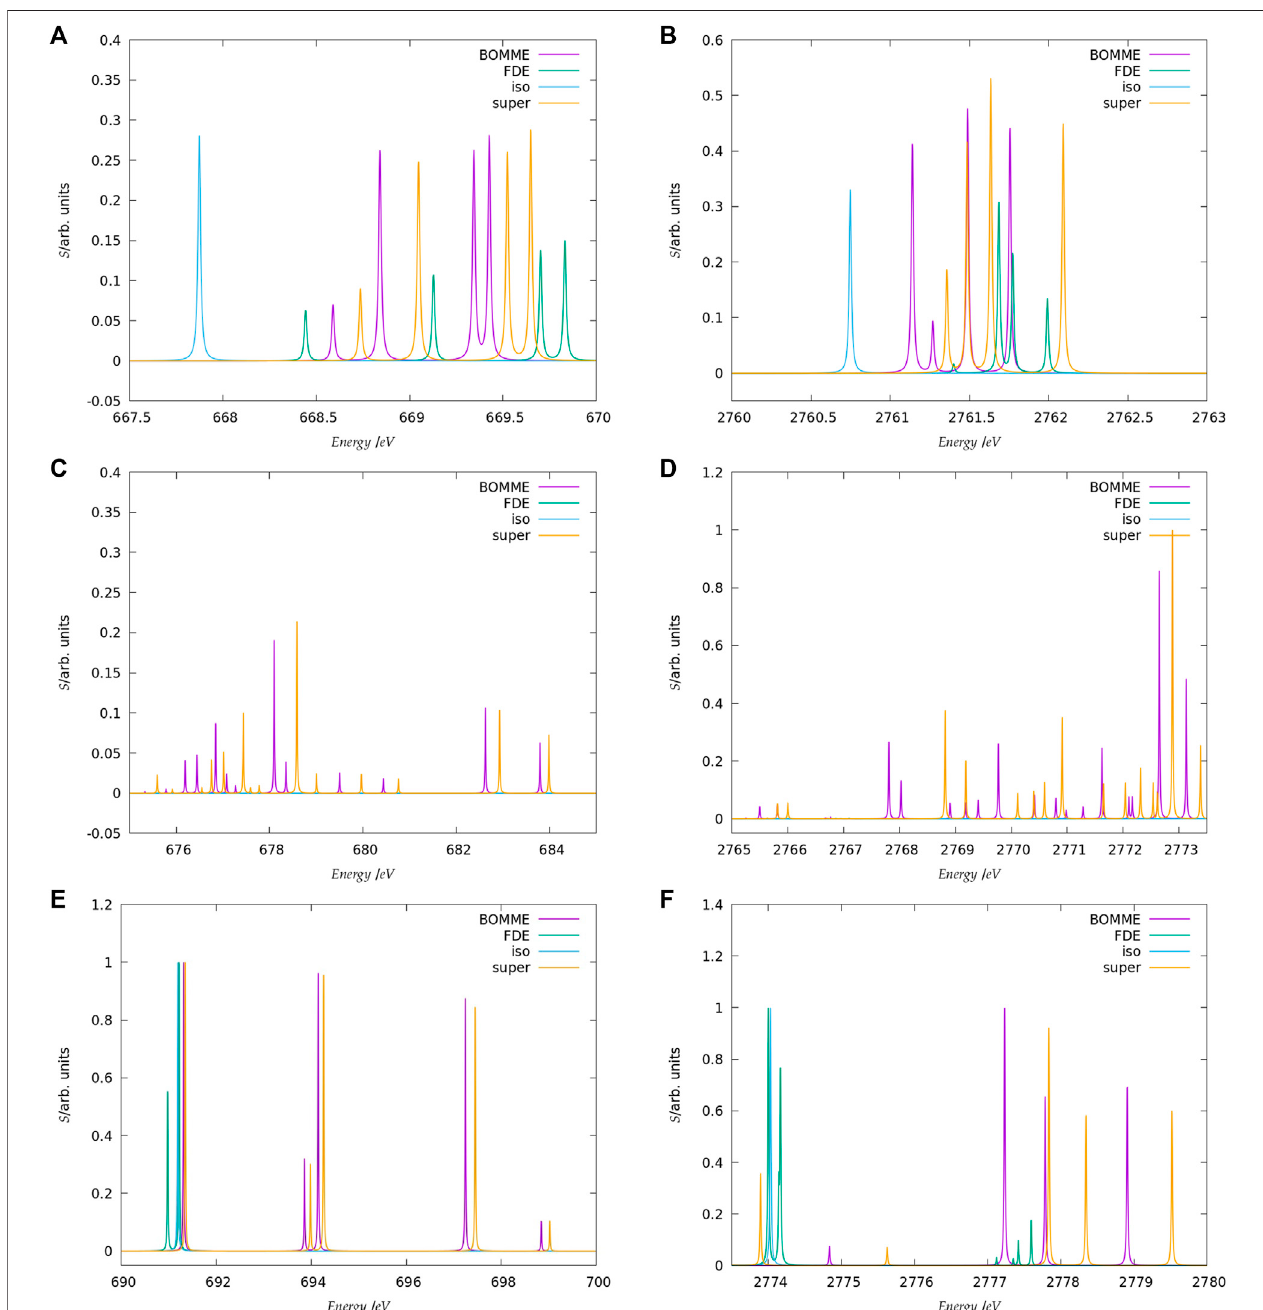
FIGURE 4 | Details on the three main energy ranges for the K-edge spectra of F − (A,C,E) and Cl − (B,D,F) model systems selected from the spectra shown in Figures 2 , 3 .